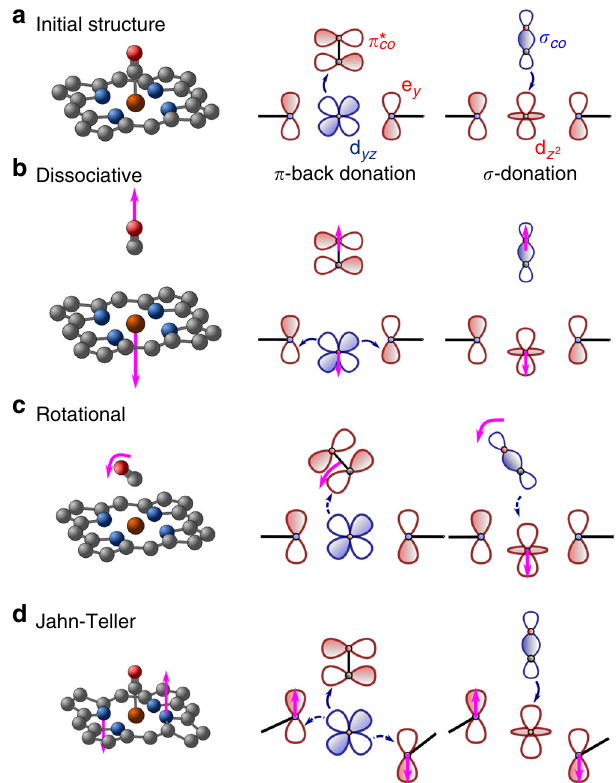
Fig. 3 Vibrational motions and effect on the Fe – CO interaction. Representation of the nuclear motions (left) and the effect on the Fe – CO orbital interaction (right). The σ CO and d xz /d yz orbitals (in blue) are occupied, while e x / y , π (cid:1) x = y ; CO and d orbitals (in red) are unoccupied. Blue z 2 arrows indicate the direction of the partial electron transfer, due to the overlap between an occupied and an unoccupied orbital (solid and dashed arrows indicate strong and weak overlap). Magenta arrows indicate the vibrational motion of the speci fi ed atoms. a In the initial structure, the = d ! π (cid:1) = π (cid:1) Fe – CO bond is strongest due to partial electron transfer d xz yz x y σ ( π -back donation) and d ( σ -donation). b Dissociative vibration, z 2 CO which corresponds to a stretching of the Fe – CO bond. This structure destabilizes the Fe – CO bond and stabilizes by a partial electron transfer d xz = d yz ! e (cid:1) x = e (cid:1) y when the Fe atom is out of plane. c Rotational vibrations, which correspond to the rotation of the CO moiety. This vibration decreases the overlap between Fe and CO orbitals. d Symmetry-breaking vibration, in which the porphyrin is distorted inducing Jahn-Teller and pseudo Jahn-Teller vibronic couplings in the excited state. This vibration has no effect on the Fe – CO bond, but activates the coupling between